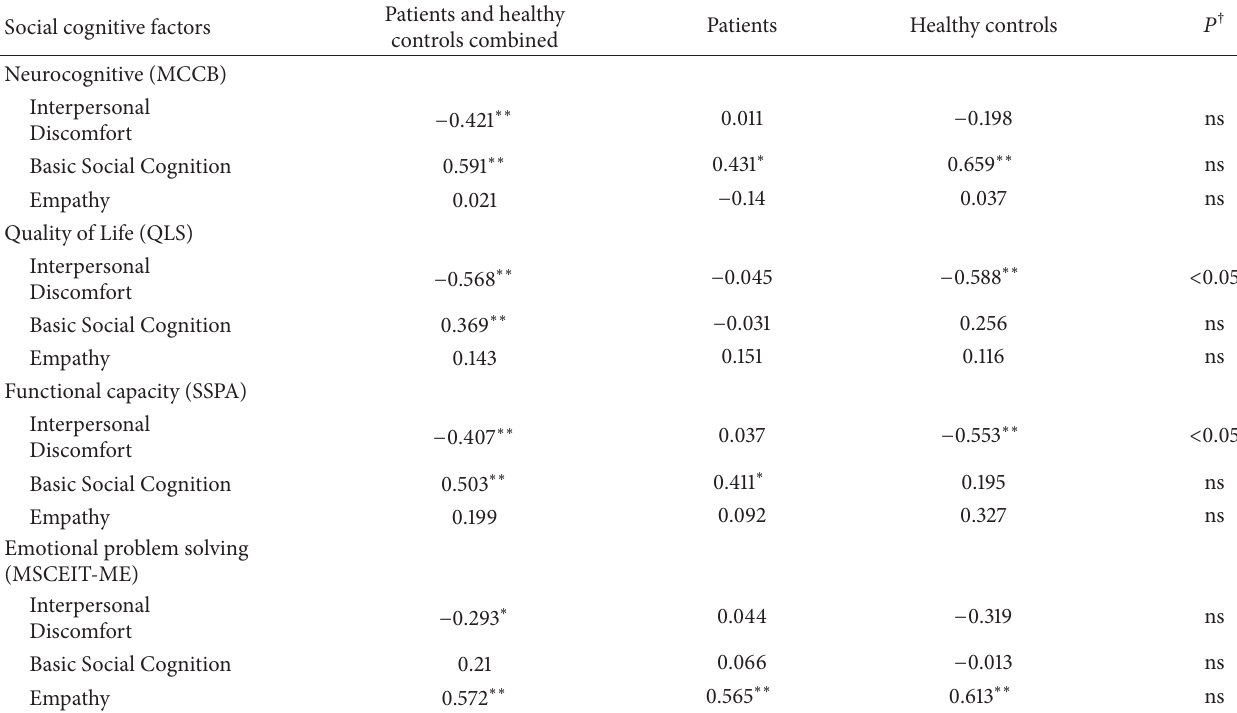
Table 6: Correlations between neurocognition, social capacity, quality of life, and emotional problem solving with the factors. Patients and healthy Patients Healthy Social cognitive factors controls combined